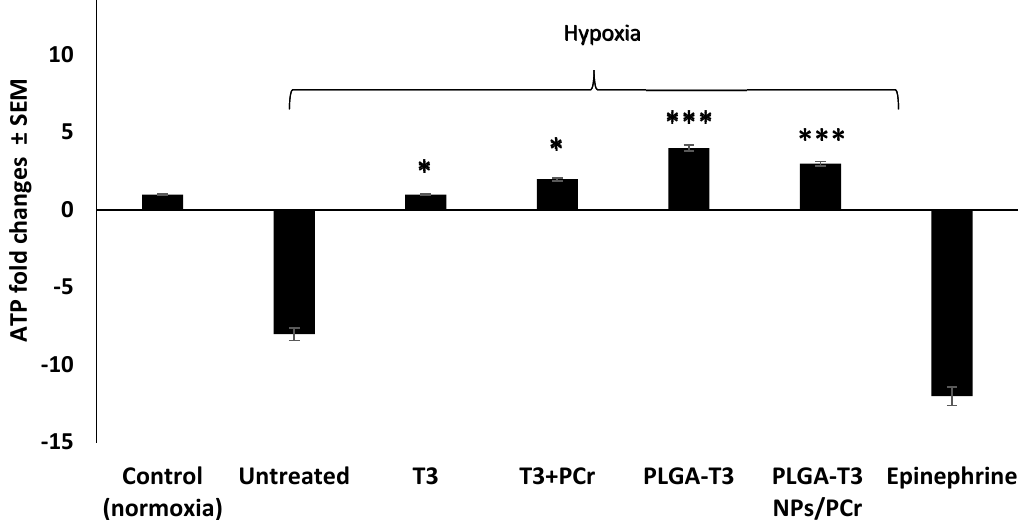
Figure 5. Cardioprotective effect of T3, PLGA-T3 NPs with or without PCr in normoxia vs. hypoxic conditions. ATP levels in neonatal cardiomyocytes (bioluminescence assay), * p < 0.01 versus hypoxia. * p < 0.01, *** p < 0.001 versus hypoxia (control untreated), with full reversal and improvement versus control under normoxic condition.).